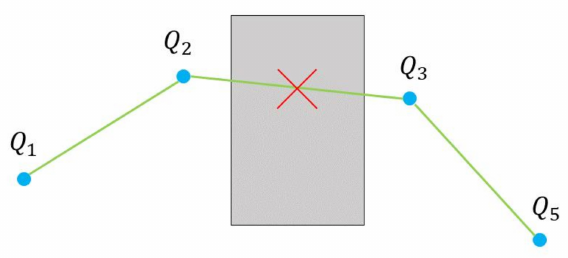
Figure 5. Schematic of the collision between the path points and the obstacles. Q 1 and Q 2 are path points, and the gray square is an